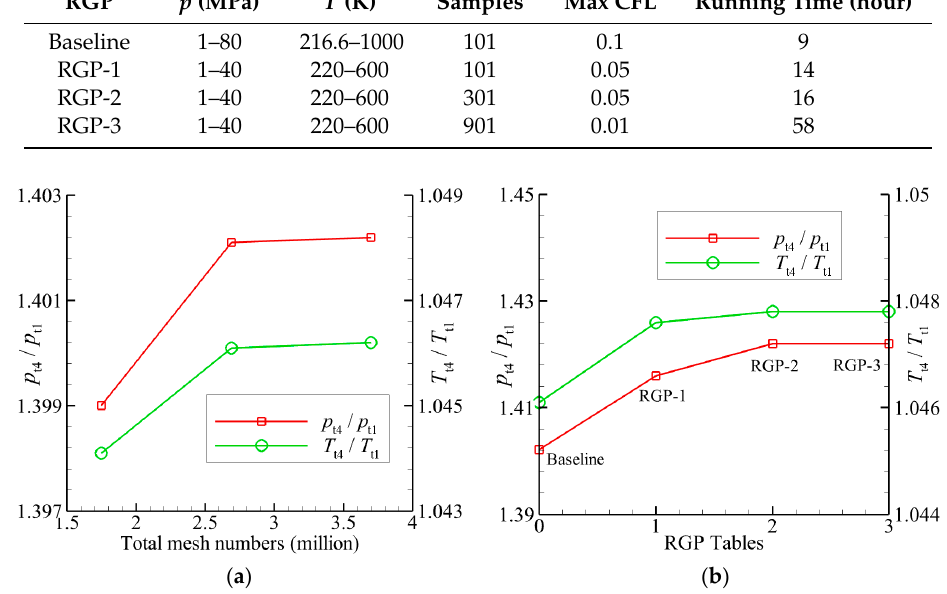
Figure 3. Independency study of the meshes and real gas property (RGP) resolution: ( a ) Mesh independency; ( b ) RGP resolution.